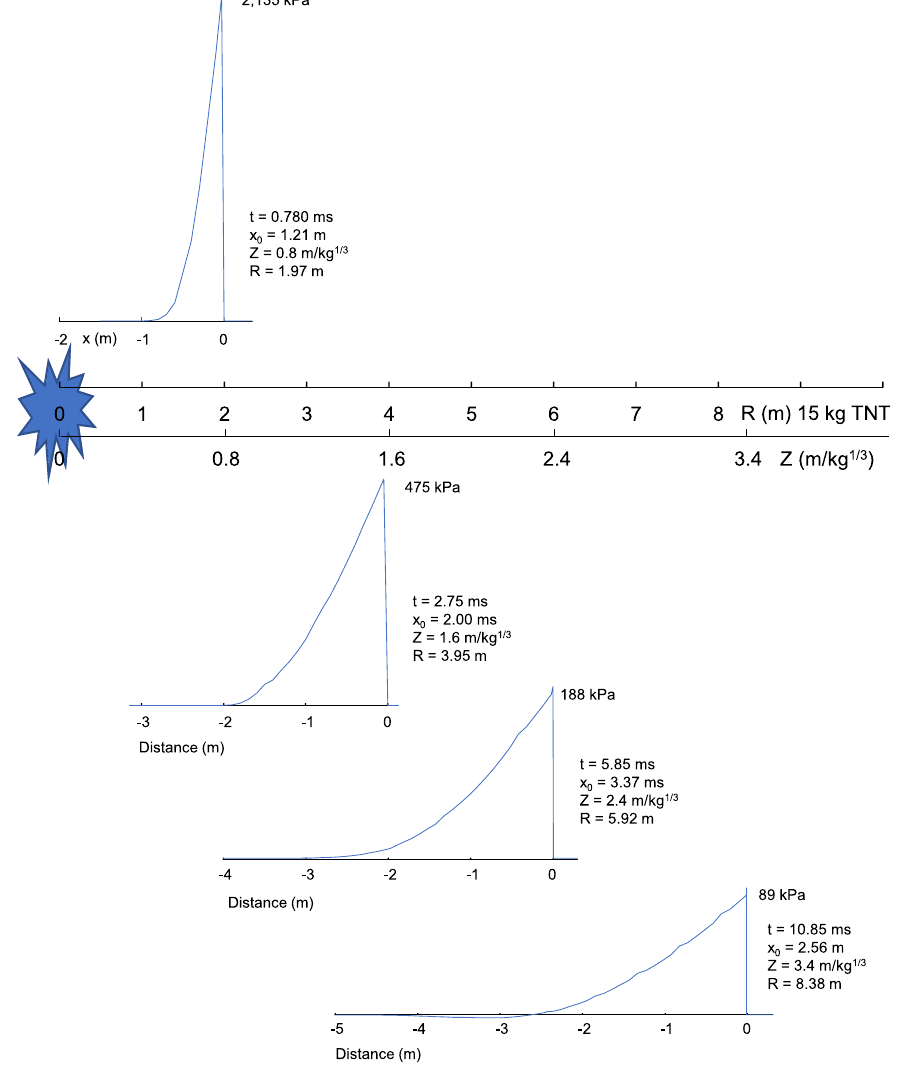
Figure 6. Shock wave characteristics versus distance behind arrival (t a ) with stand-off